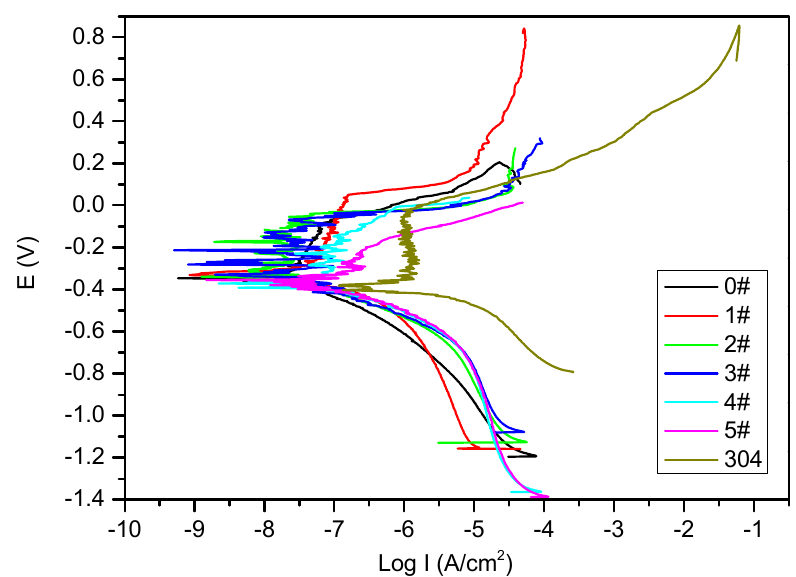
Figure 6. Potentiodynamic polarization curves of C:Ti–O films.